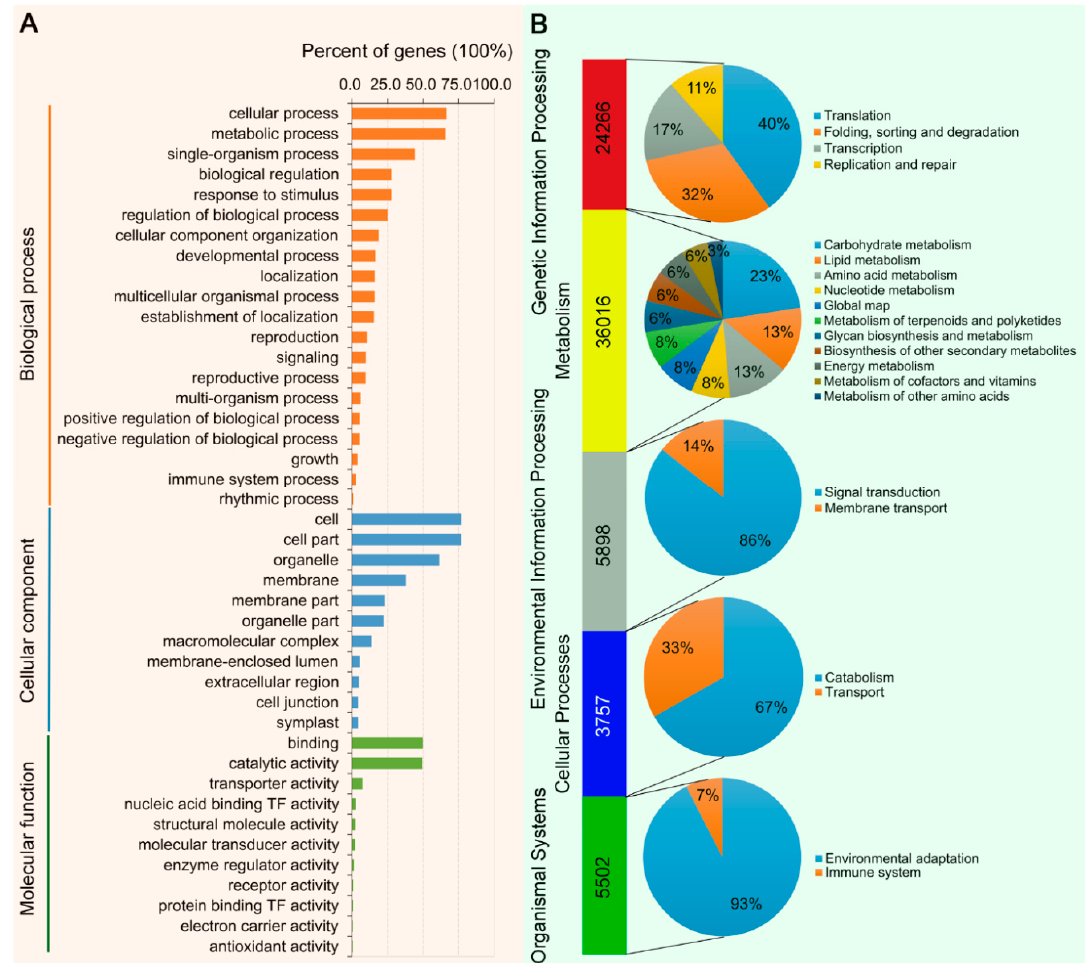
Figure 3. Classification of enriched Gene Ontology (GO) and Kyoto Encyclopedia of Genes and Genomes (KEGG) terms. ( A ) A total of 96,374 unigenes were assigned to different GO terms. ( B ) A total of 75,439 unigenes were assigned to different KEGG terms.